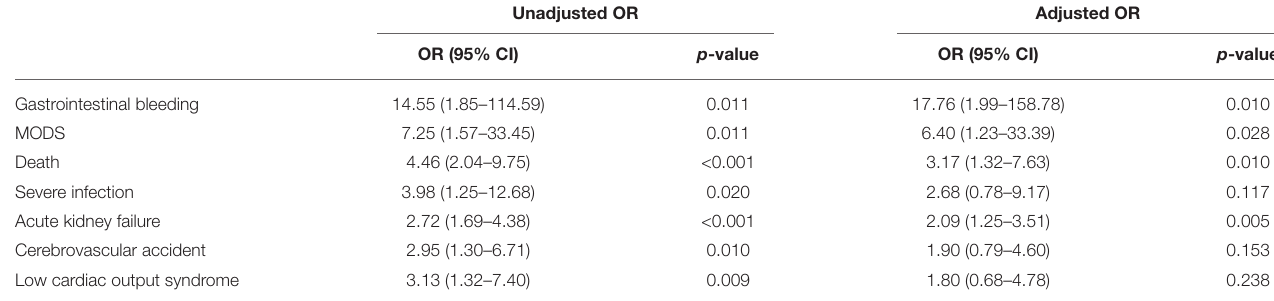
TABLE 3 | Odds radio by D-dimer levels for